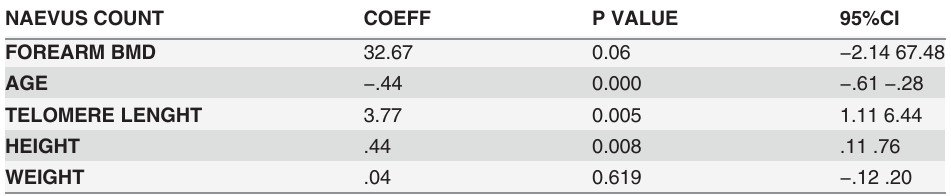
Table 4. Multivariate Linear Regression for the association between naevus count and forearm BMD (Robust regression) (n =